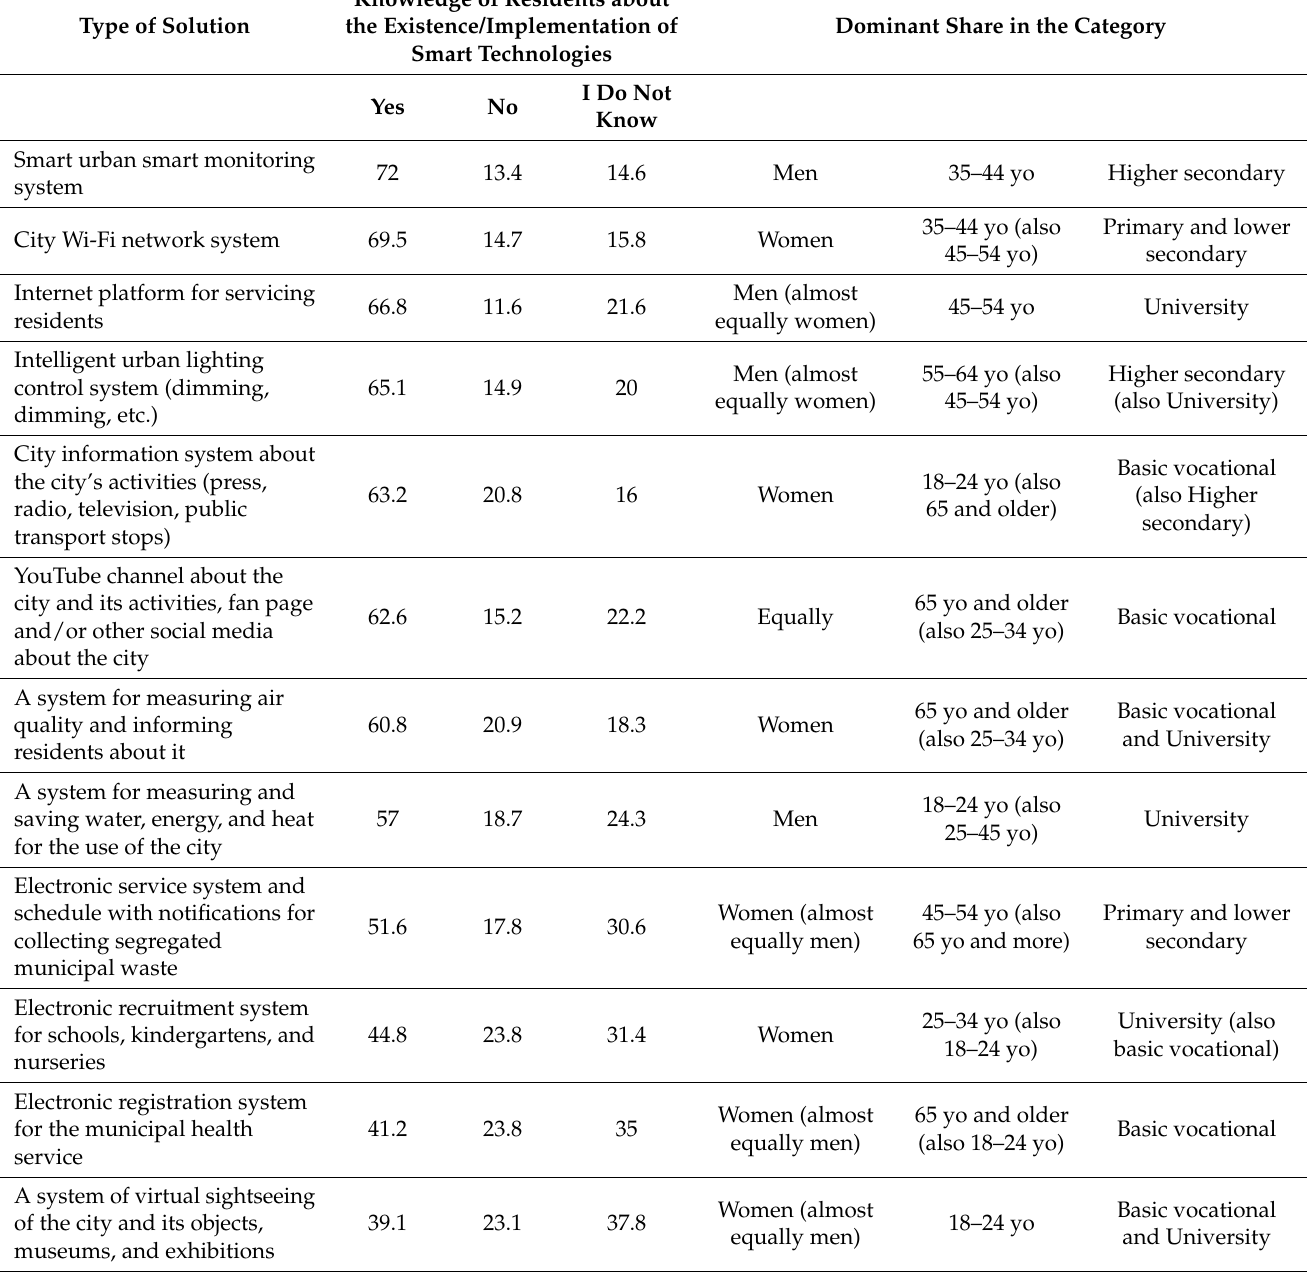
Table 2. Knowledge of residents about the existence/implementation of smart